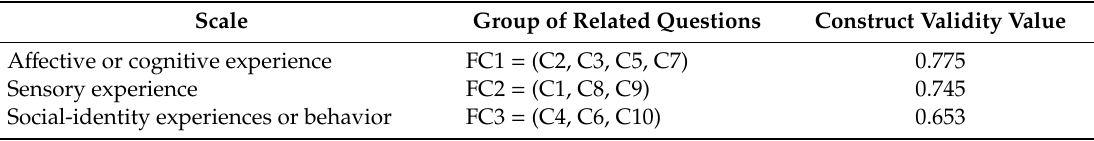
Table A12. Construct validity values of the three scales of the indicator of “writer’s